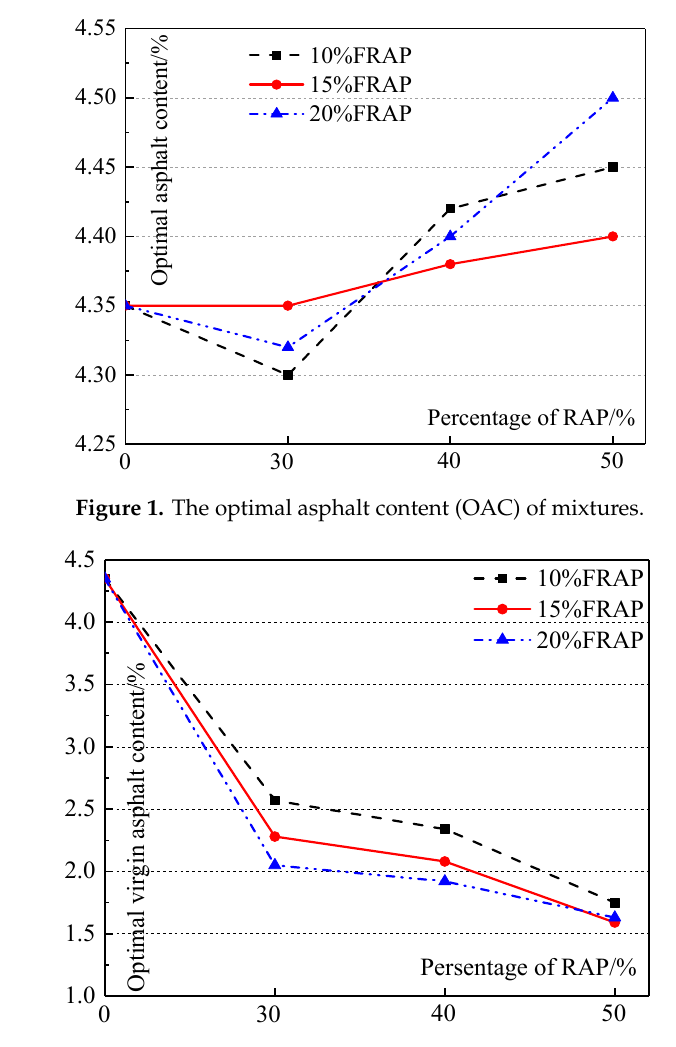
Figure 2. The virgin asphalt content used in recycled mixtures.